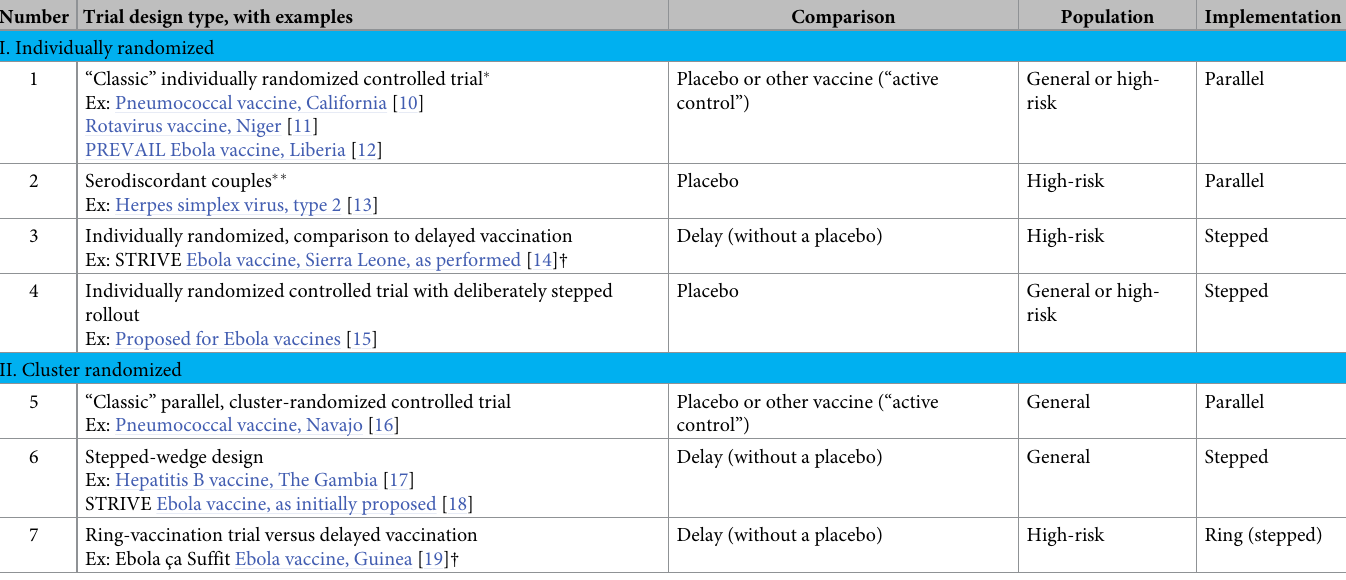
Table 1. Possible trial designs to evaluate the efficacy of investigational vaccines during epidemics of emerging infectious diseases. The table does not provide an exhaustive list, and not all designs have been used for evaluating vaccines against emerging infectious diseases. Number Trial design type, with